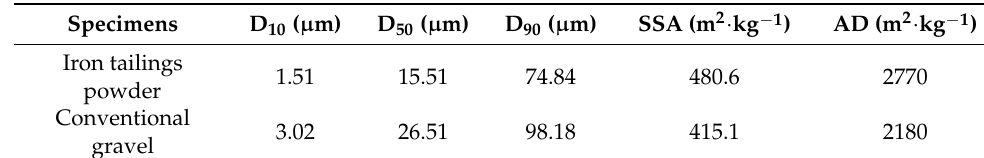
Figure 5. Particle size distribution curves of two mineral admixtures. Table 2. Primary technical indices of Portland cement.